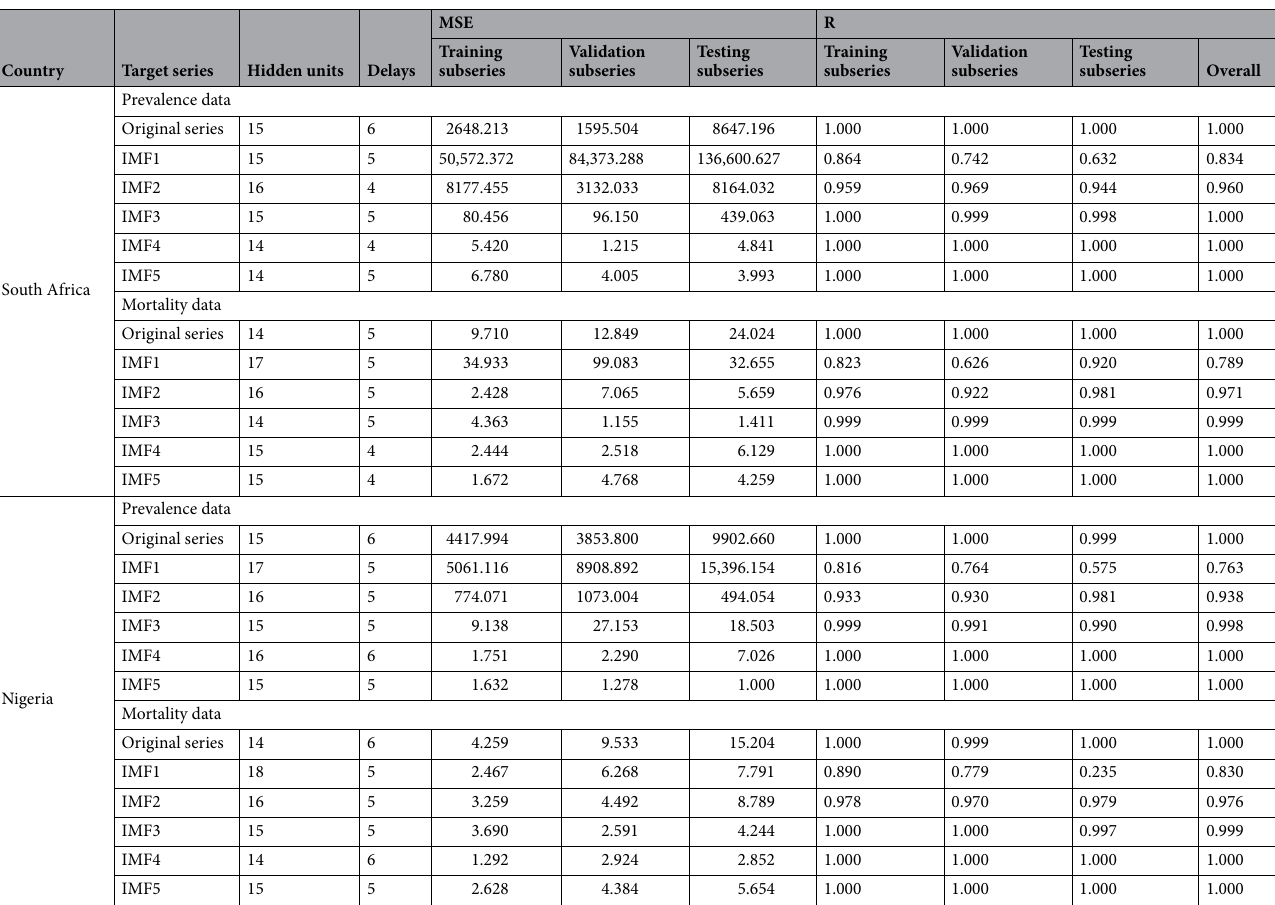
Table 4. The identified parameters of the best NARANN and EEMD-ARIMA-NARANN hybrid models for different target series. MSE mean square